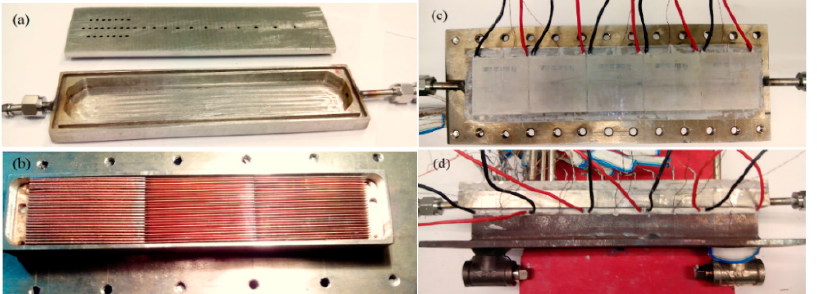
Figure 1. Methanol steam reforming reactor coupled with thermoelectric power generation mod- ules: ( a ) reforming channel; ( b ) heating channel; ( c ) thermoelectric modules arrangement; and ( d ) reactor assembling.